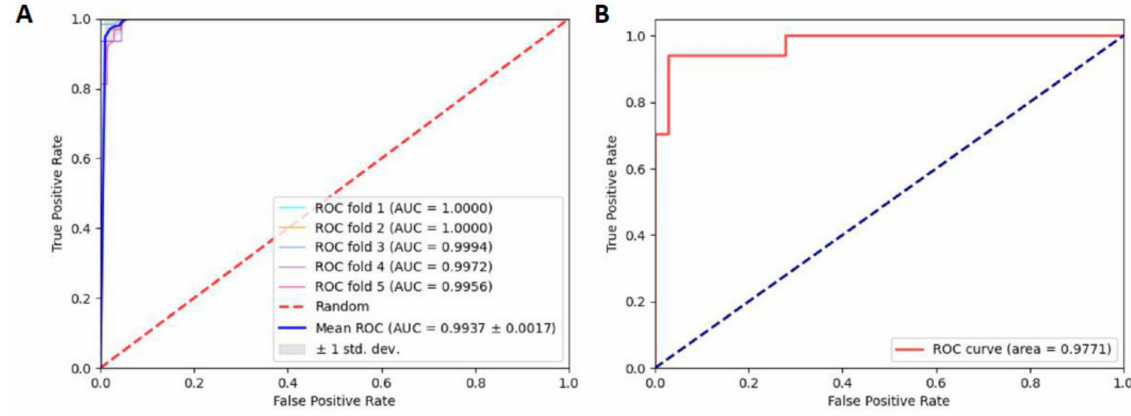
Figure 2. ( A ) ROC curve under the 5-fold CV. ( B ) ROC curve under independent test.